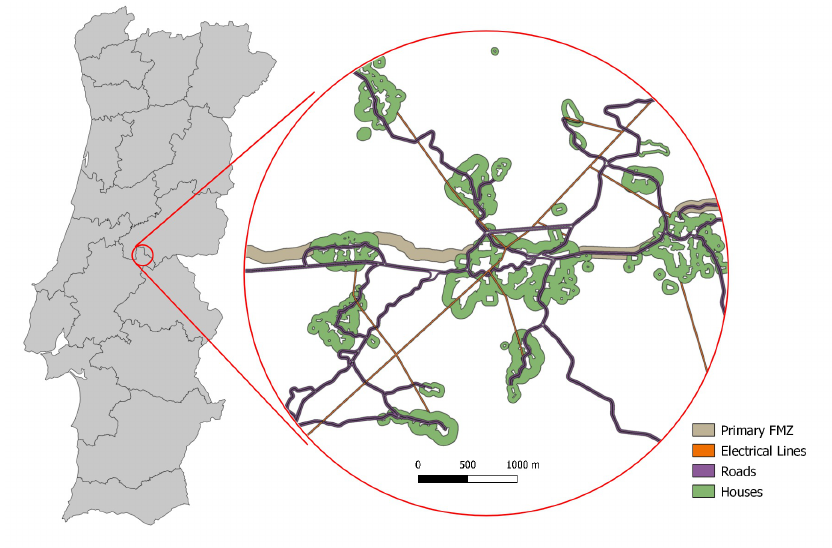
Figure 1. Study area and some Fuel Management Zones (FMZs) in vector format in the zone of Cardigos, Mação. Please note that the images are not in scale.